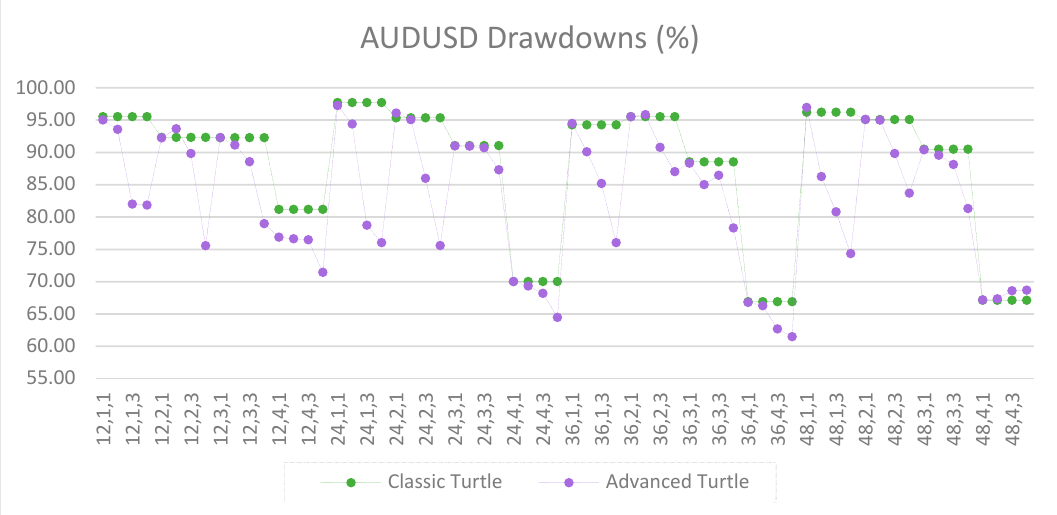
Figure A17. Net profits of AUDUSD between the classic and the advanced Turtle systems for every combination of N, X, Y for the medium parameters (40, 80).